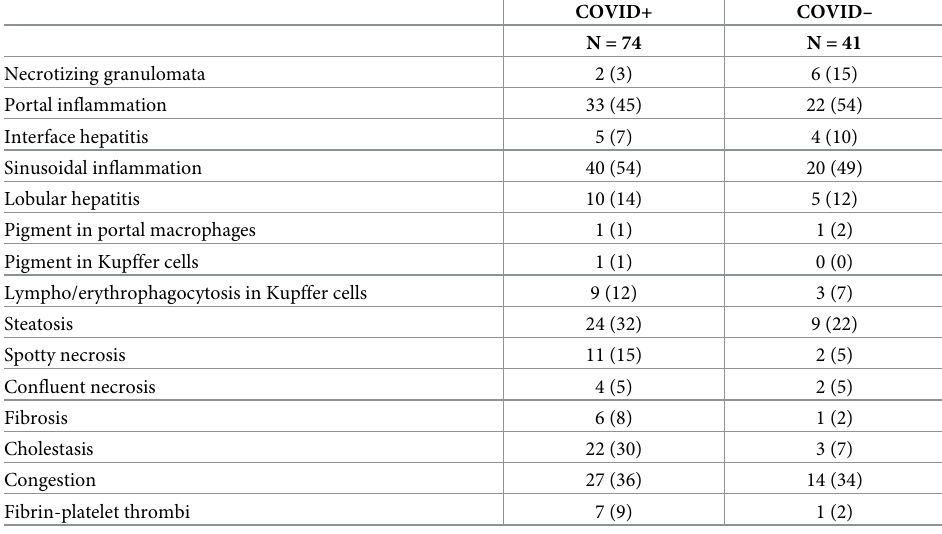
higher among COVID+ than COVID- decedents. Hyaline membrane formation was 50% higher in the COVID+ than COVID- group. These changes reflect the sequence of events that are triggered by SARS-CoV-2 infection of Type-II pneumocytes and possibly Type I pneumo- cytes, leading to cellular injury, altered surfactant production/function and with coexistent endothelial injury, resulting in capillary leakage, fluid and protein accumulation in alveolar spaces and hyaline membrane formation [22, 33]. Repair follows with Type-II pneumocytes acting as progenitor cells, initially differentiating into transitional Type-II pneumocytes and then into Type-I pneumocytes restoring the alveolar epithelium. Using two different classifica- tion methods, the COVD+ decedents displayed substantially higher rates for each stage of damage and repair within the lung. Given the paucity of data from Africa, these results may be Table 6. Histopathology heart features in decedents hospitalized with respiratory illness with (COVID+) and without (COVID–) SARS-CoV-2 infection. COVID+ COVID– n = 68 n = 37 Neutrophilic infiltrate 1 (1) 1 (3) Lymphocytic infiltrate 6 (9) 6 (16) Histiocytic infiltrate 6 (9) 10 (27) Eosinophilc infiltrate 0 (0) 0 (0) Myocardial fibre necrosis 7 (10) 8 (22) Vasculitis 0 (0) 0 (0) Fibrinplatelet thrombi/microthrombi 2 (3) 1 (3) Interstitial oedema 4 (6) 4 (11) Myocardial fibre hypertrophy 41 (60) 24 (65) Interstitial fibrosis 35 (51) 18 (49) Results are n (%).